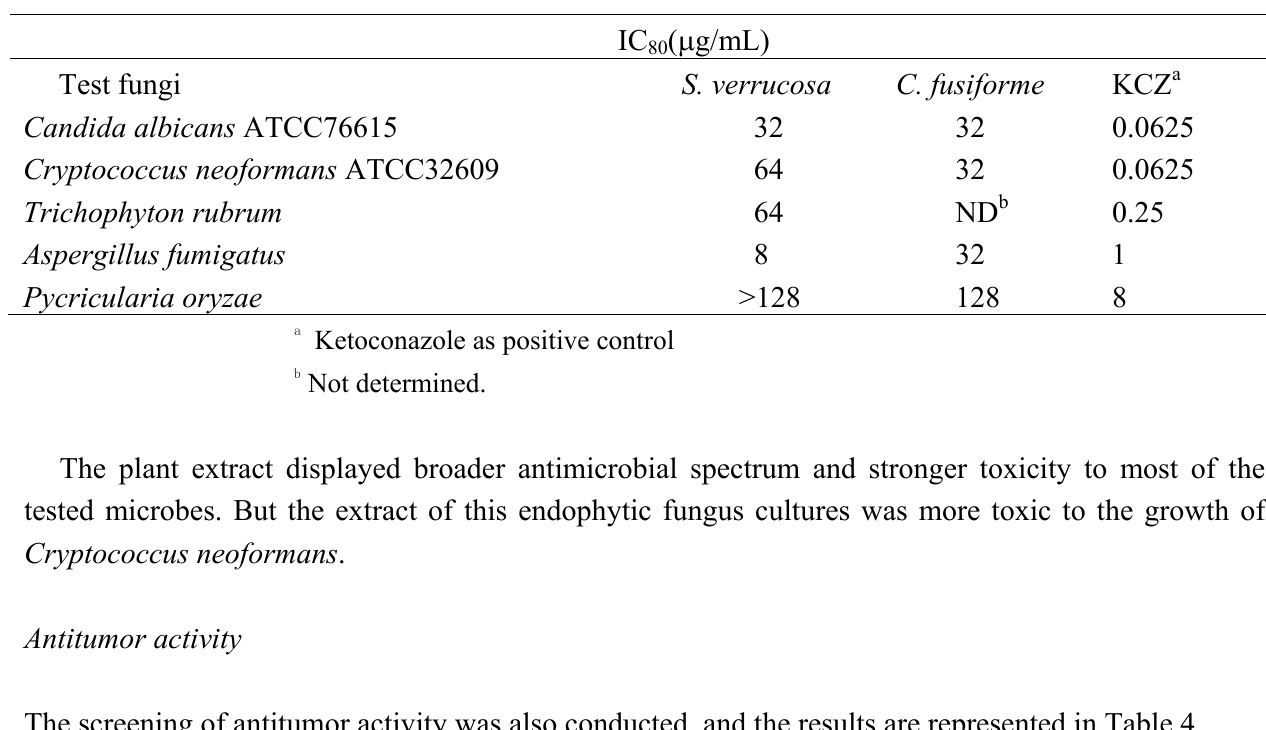
Table 3. Antimicrobial activity of the ether extract of S. verrucosa and C. fusiforme .